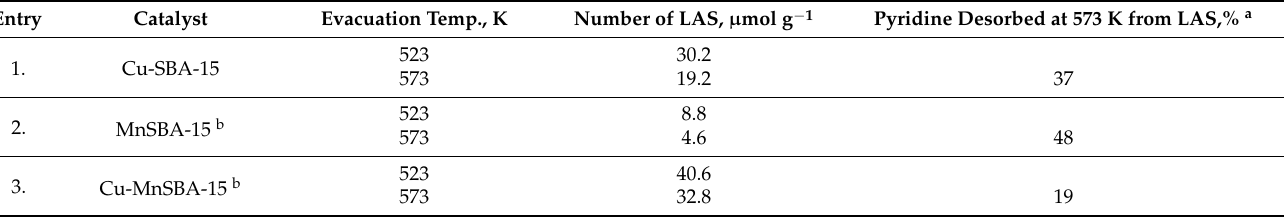
Table 3. The number of Lewis acid sites (LAS) occupied by pyridine after adsorption at 423 K and desorption at different temperatures (calculated on the basis of the extinction coefficient from [34], ε 1450 = 2.22 µ mol − 1 cm).